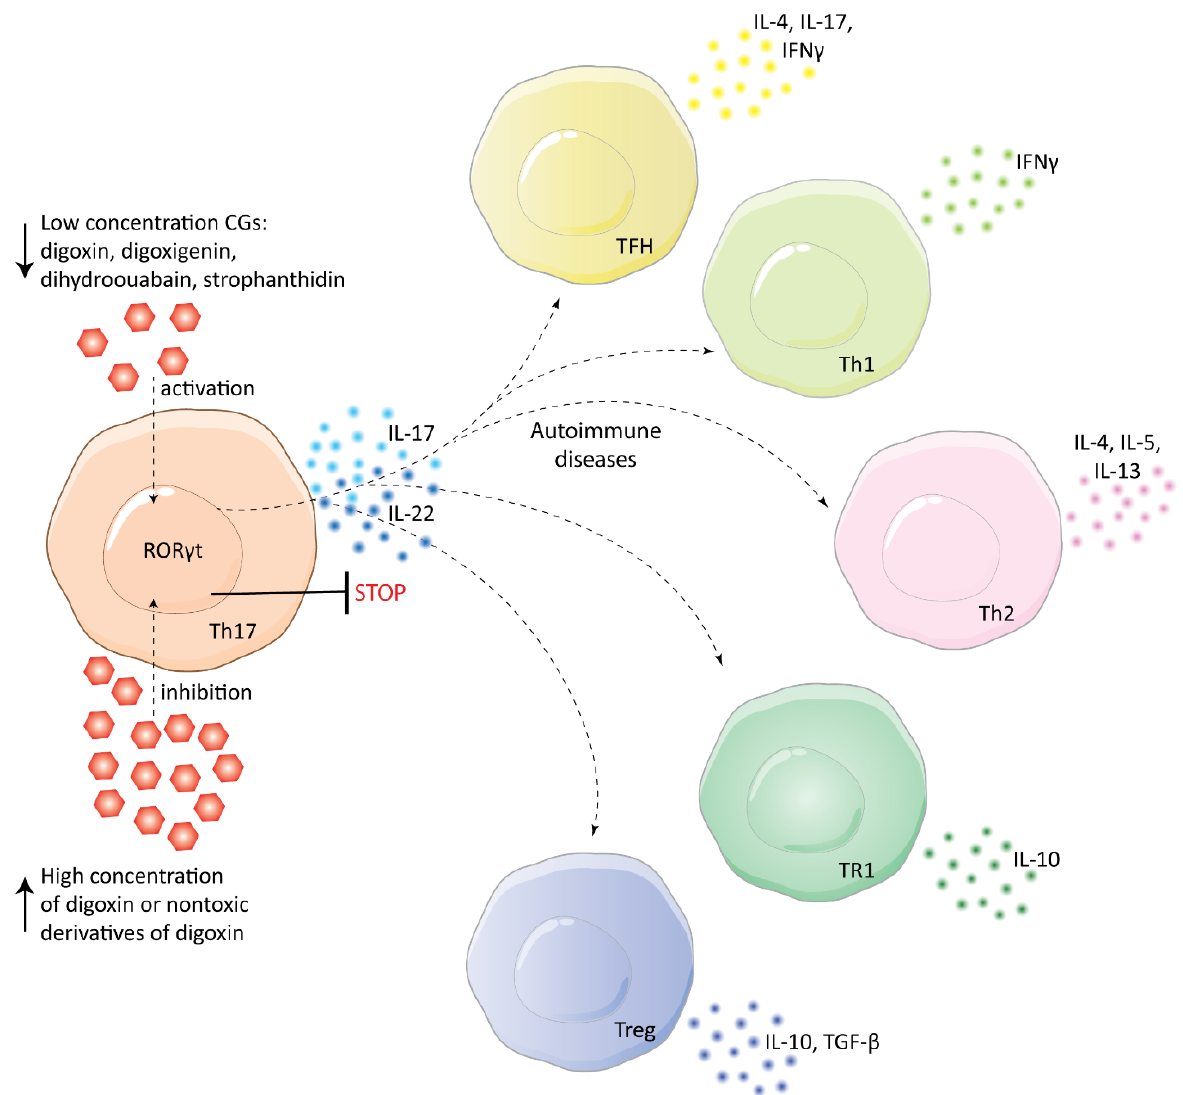
Figure 4. Cardiac glycosides at low nanomolar concentrations activate ROR γ t, whereas at high concentrations they cause ROR γ t transcriptional inhibition. This influences the production of interleukins (IL) 17 and 22 in T-helper cells expressing IL-17 (Th17). The interleukins promote autoimmune diseases by activating immune cells, such as follicular B-helper T cells (TFH), type 1 and type 2 T-helper cells (Th1, Th2), type 1 regulatory T cells (TR1), and regulatory T cells (Treg). These cells produce IL, interferon γ (IFN γ ), or transforming growth factor-beta (TGF- β